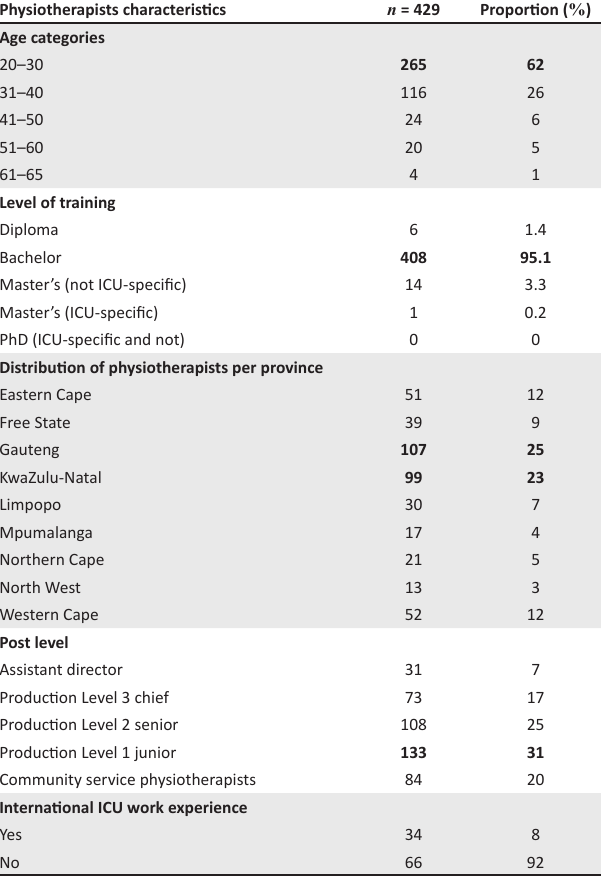
TABLE 2: Profile of physiotherapists working in public-sector physiotherapy departments which service intensive care units. Physiotherapists characteristics